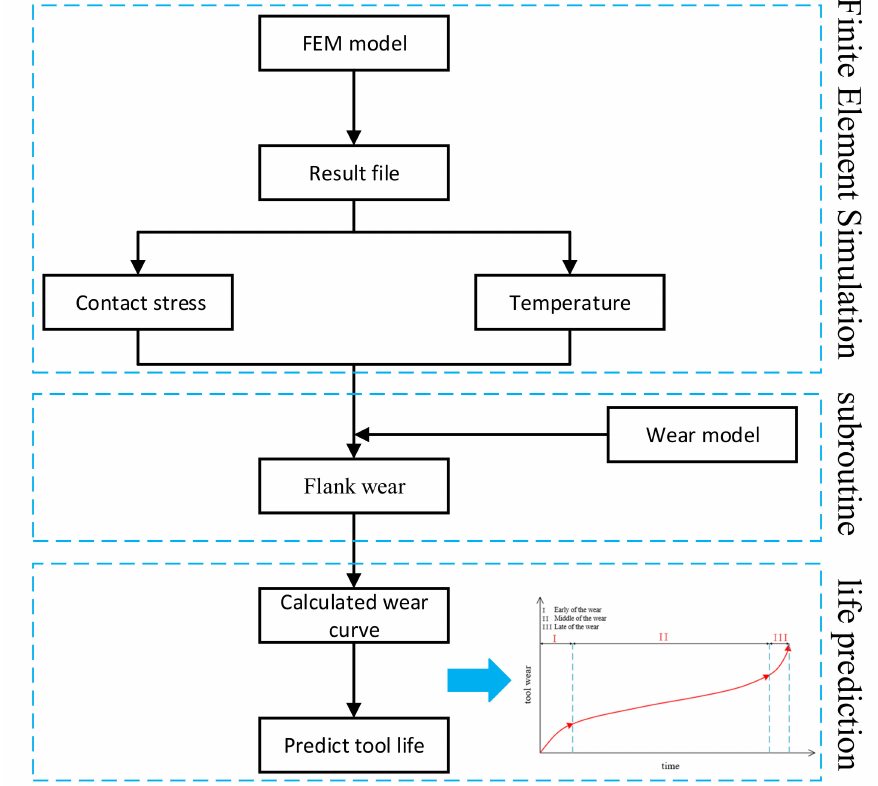
Figure 1. Flow chart of abrasion